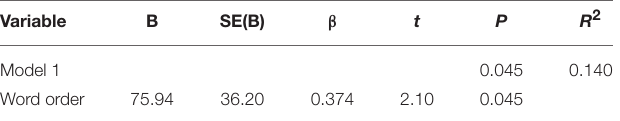
TABLE 10 | Stepwise regression analysis for variables predicting visit 6 object—what question comprehension in children with ASD ( N = 29). Variable